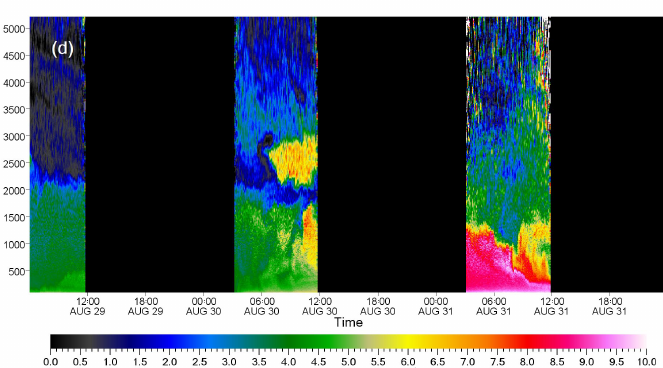
Figure 14. False-color lidar plots for 29–31 August for (a) ozone, (b) backscatter ratio, (c) depolarization ratio and (d) water vapor (nighttime